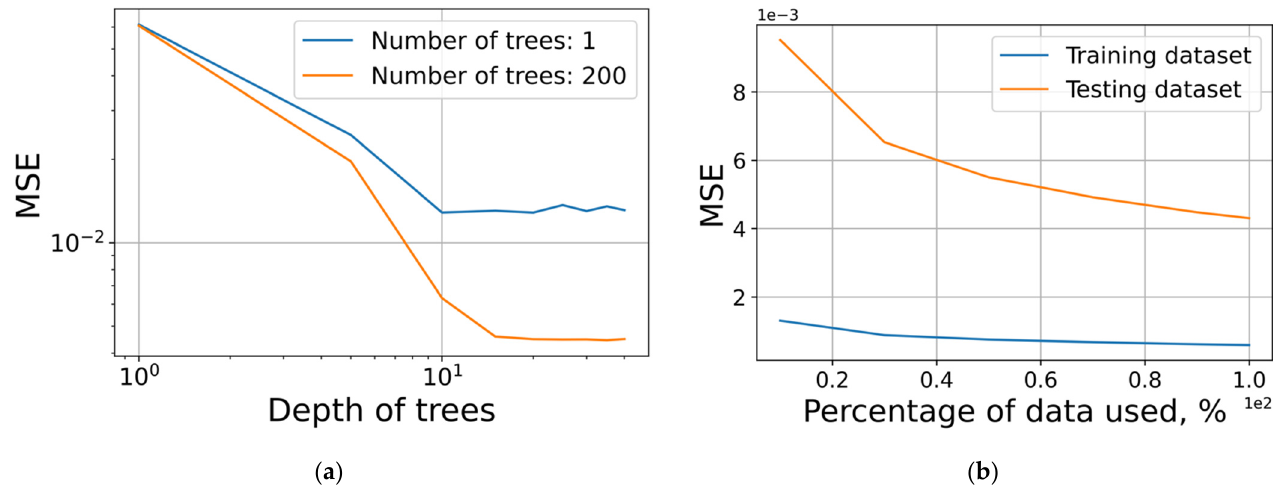
Figure 9. MSE loss function for: ( a ) different number and depth of trees; ( b ) percentage of dataset used in training and test.